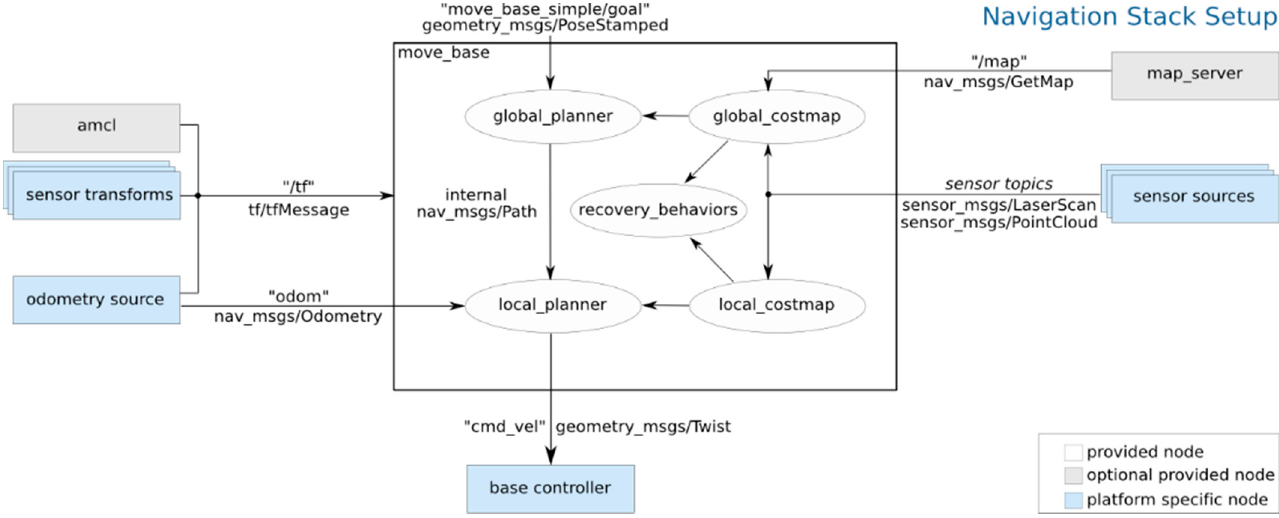
Figure 7. Move base node for the navigation stack.